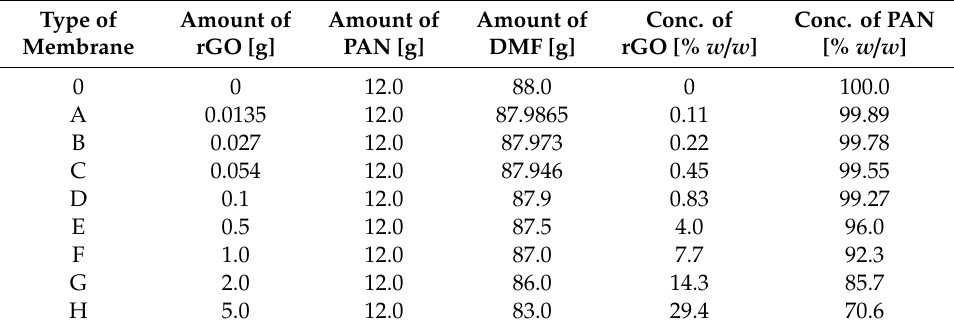
Table 1. The composition of the solutions used for the membrane